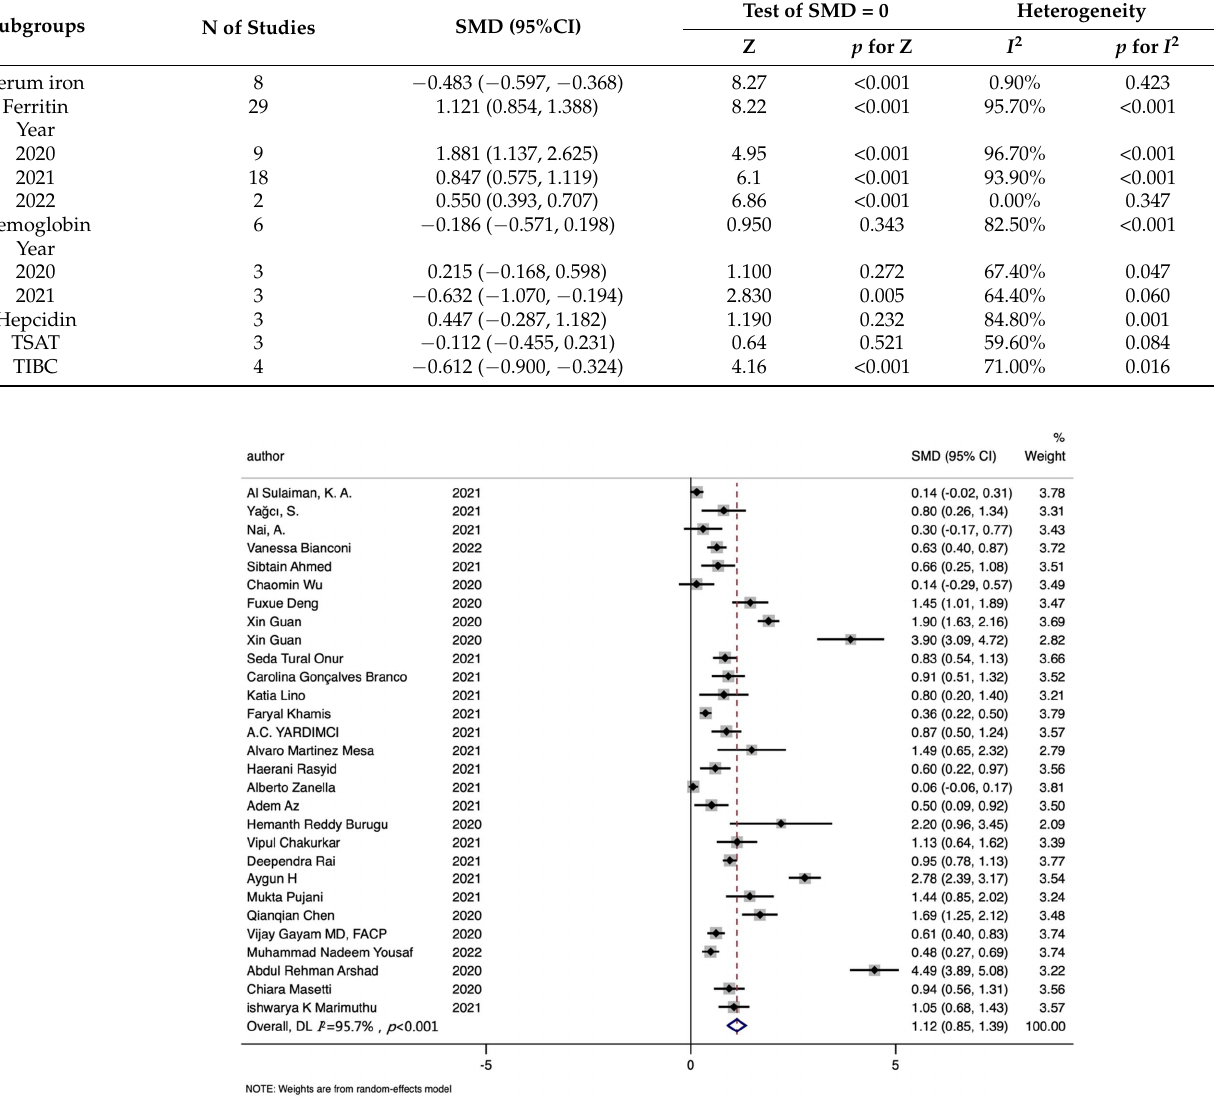
Figure 2. Forest plot of standard mean difference (SMD) with corresponding 95% confidence intervals (CIs) of studies [8,10–13,30,38–40,46–64] on ferritin levels in non-survivors and survivors. The solid diamond and horizontal line represent the study-specific effect and 95%CI, respectively; the size of the grey square is positively correlated with the weight distributed to each study in the meta-analysis. The center of open diamond with the vertical dashed line expresses the pooled SMD, and the width expresses the pooled 95%CI.